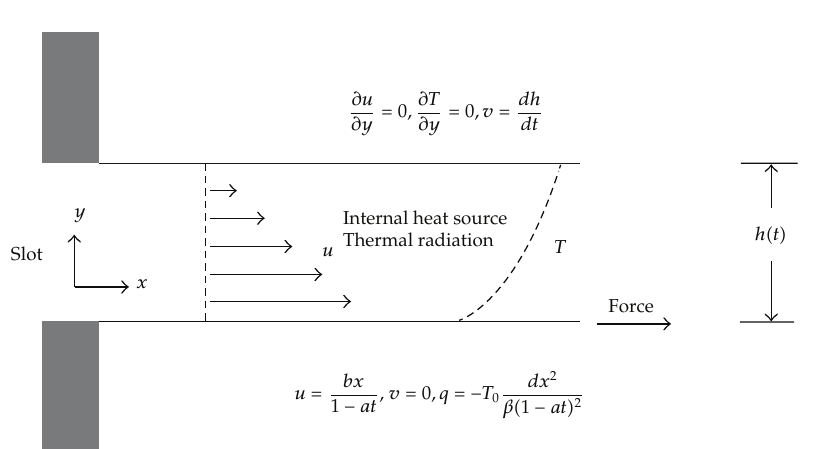
Figure 1: Schematic diagram of the physical